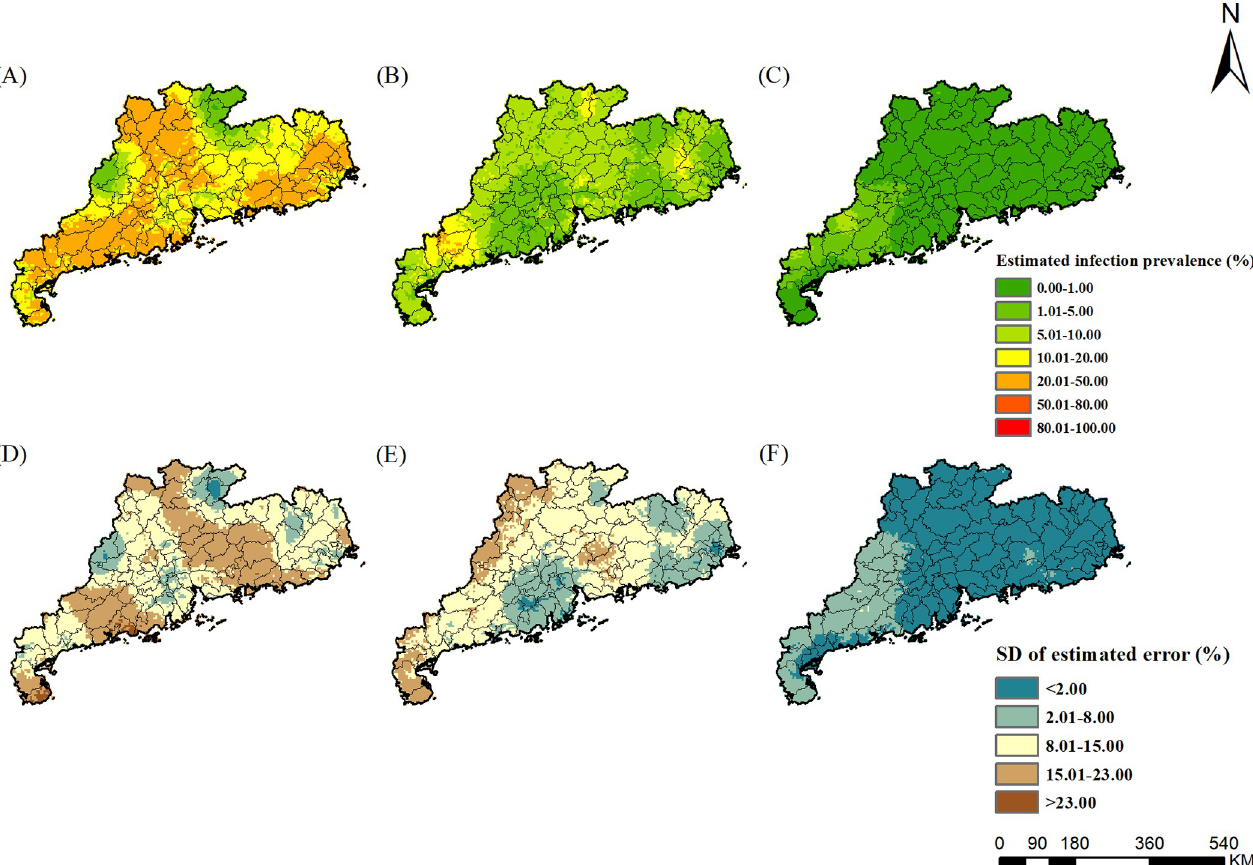
Fig 4. The geographical distribution of hookworm infection risk in Guangdong. (A)-(C) present hookworm infection during the periods of 1988–1992, 2002–2003, and 2015–2016, respectively. (D)-(F) present the corresponding standard deviation of the estimated uncertainty. The base layer derived